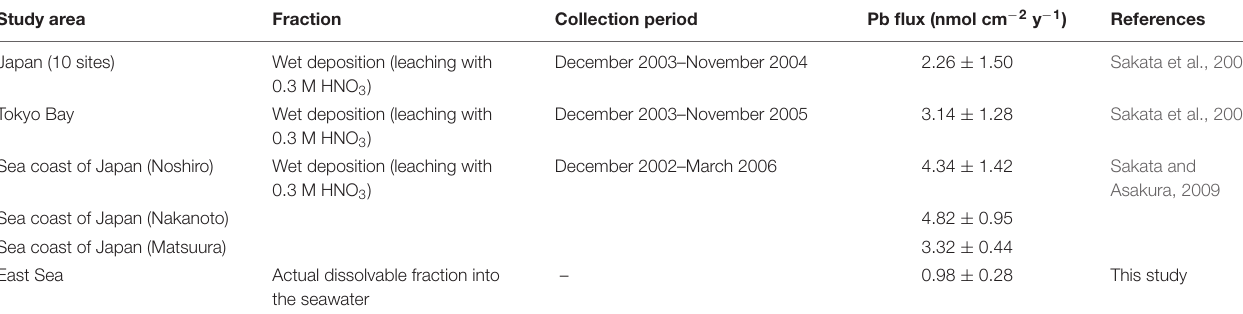
TABLE 2 | Comparison of atmospheric depositional fluxes of Pb (nmol cm − 2 y − 1 ) around the East Sea. Study